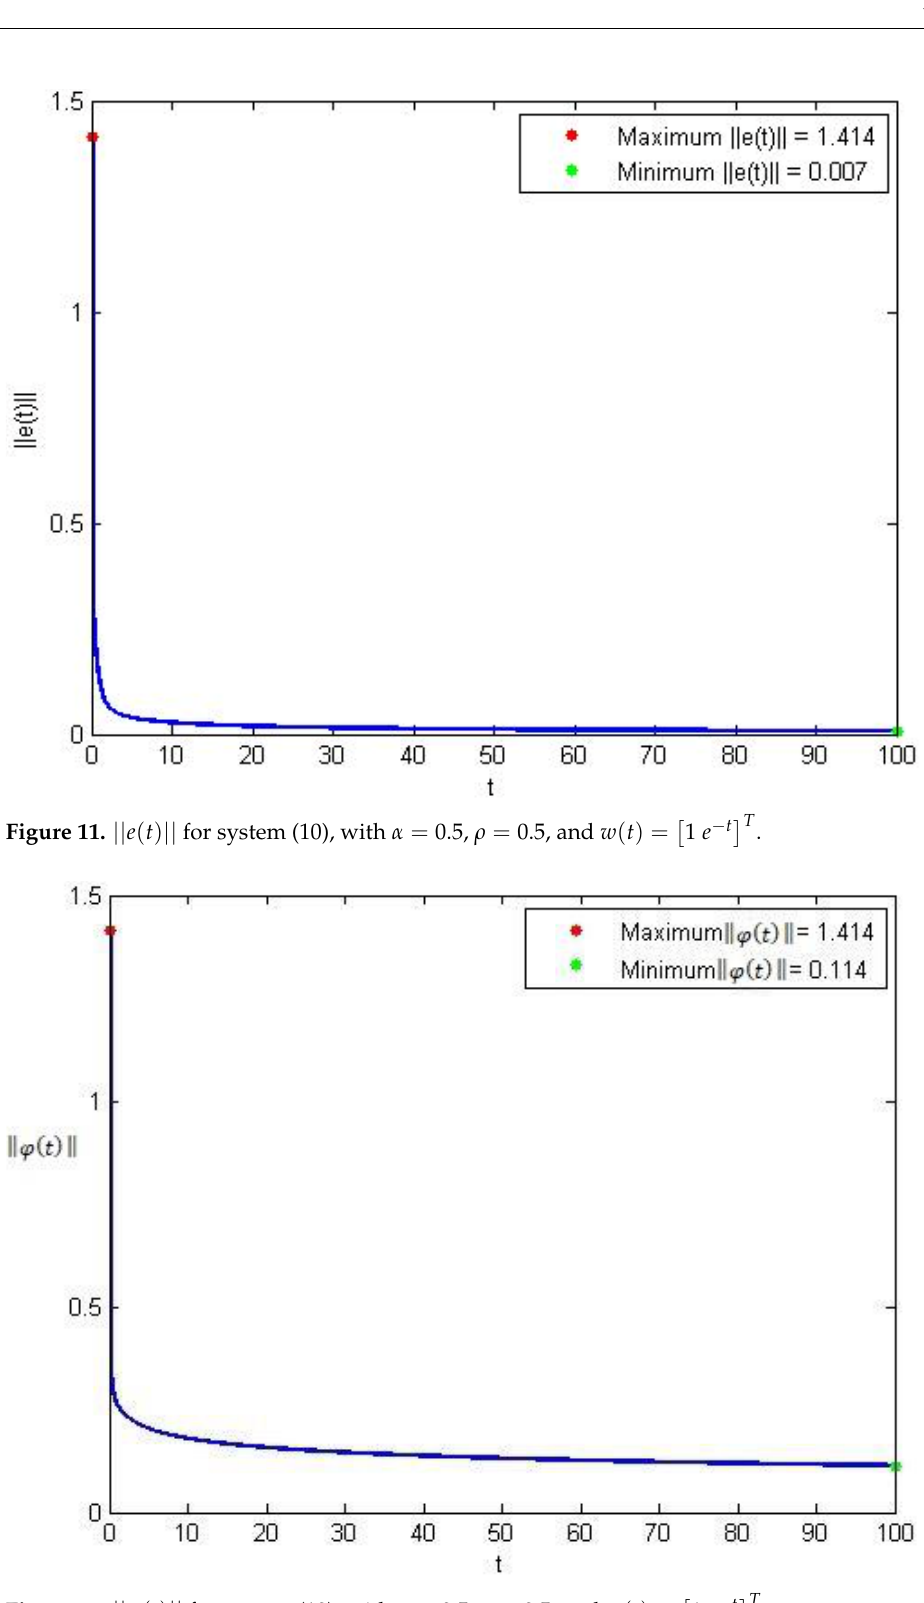
Figure 12. || ϕ ( t ) || for system (10), with α = 0.5, ρ = 0.5, and w ( t ) = Figure 12. ‖𝜑(𝑡)‖ for system (10), with 𝛼 = 0.5 , 𝜌 = 0.5, and 𝑤(𝑡) = [1 𝑒 −𝑡 ] 𝑇 .